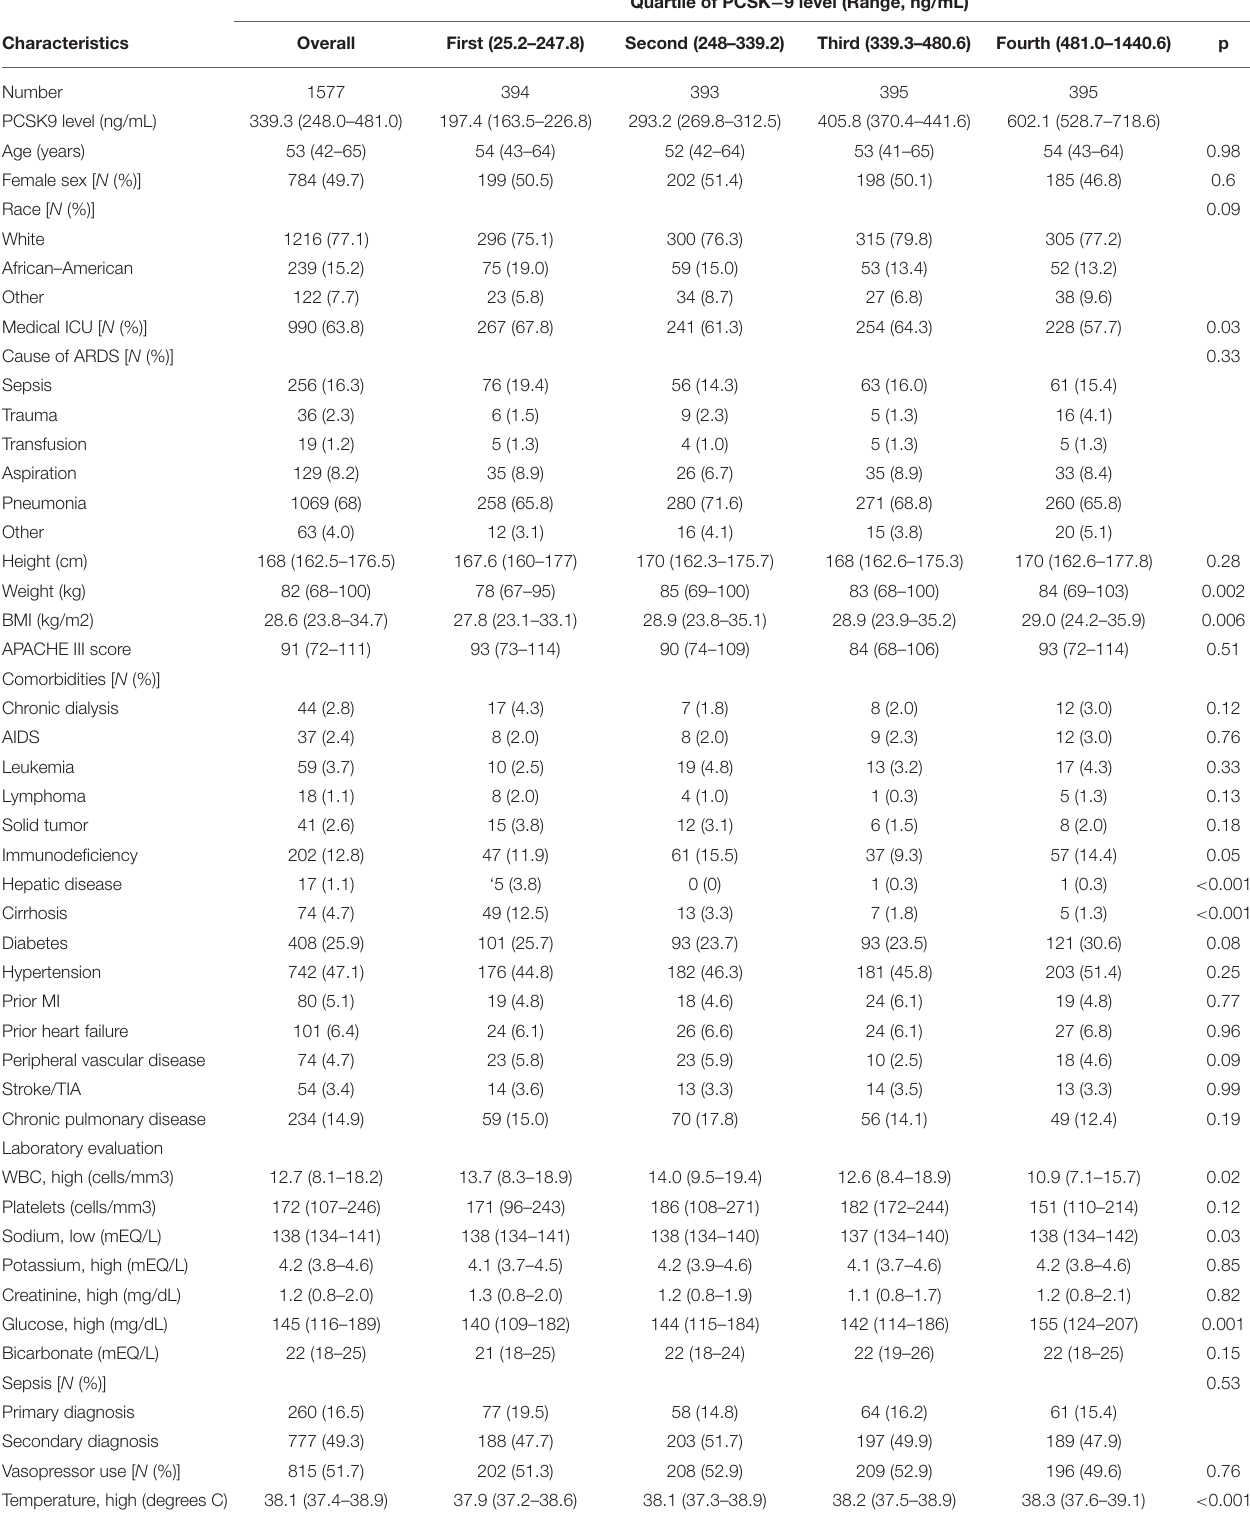
TABLE 1 | Characteristics of study participants by quartile of PCSK9